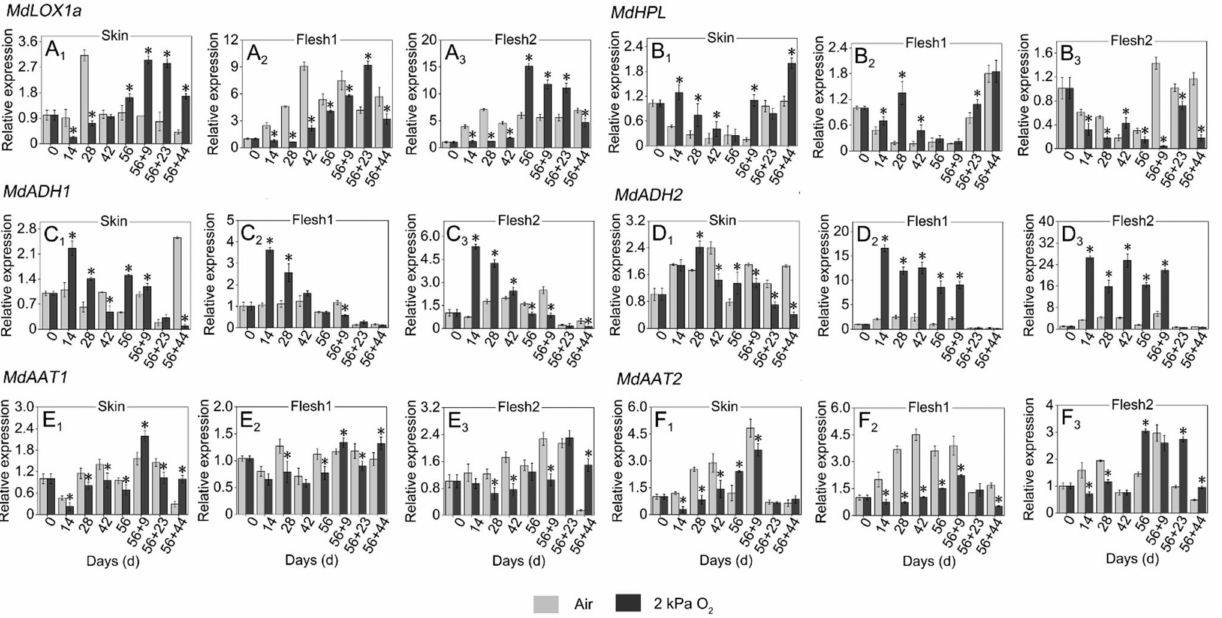
Figure 4. Expressions of genes involved in fatty acid metabolism pathway coding for enzymes found in the skin and flesh of ‘Golden Delicious’ apple fruit throughout 56-day storage under 2 kPa O 2 + 98 kPa N 2 at 4 ◦ C and subsequent 44-day shelf life at 20 ◦ C. The expressions of MdLOX1a , MdHPL , MdADH1 , MdADH2 , MdAAT1 and MdAAT2 are shown in ( A 1 – A 3 , B 1 – B 3 , C 1 – C 3 , D 1 – D 3 , E 1 – E 3 and F 1 – F 3 ), respectively. Air represents apple fruit stored in air; 2 kPa O 2 represents fruit stored under 2 kPa O 2 + 98 kPa N 2 . Skin indicates tissue obtained 0 − 0.1 mm of top pericarp; Flesh1 and Flesh2 indicate flesh tissues obtained, respectively, 0.1 − 1.0 cm and 2.0 − 3.0 cm below the exocarp. Bars indicate standard deviation for each mean value from at least three replicates. Asterisks indicate significant difference between air-stored and 2 kPa O 2 -stored fruit at p < 0.05 (Duncan’s multiple range